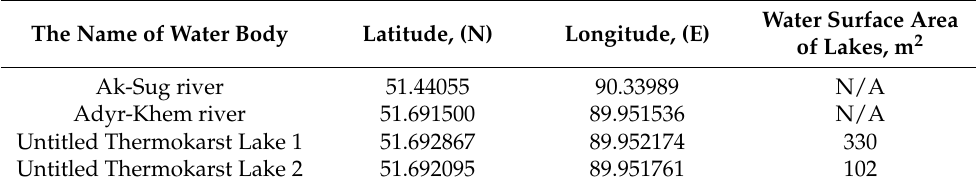
Table 1. Location of test sites for physicochemical and microbiological analysis in the open water bodies. The Name of Water